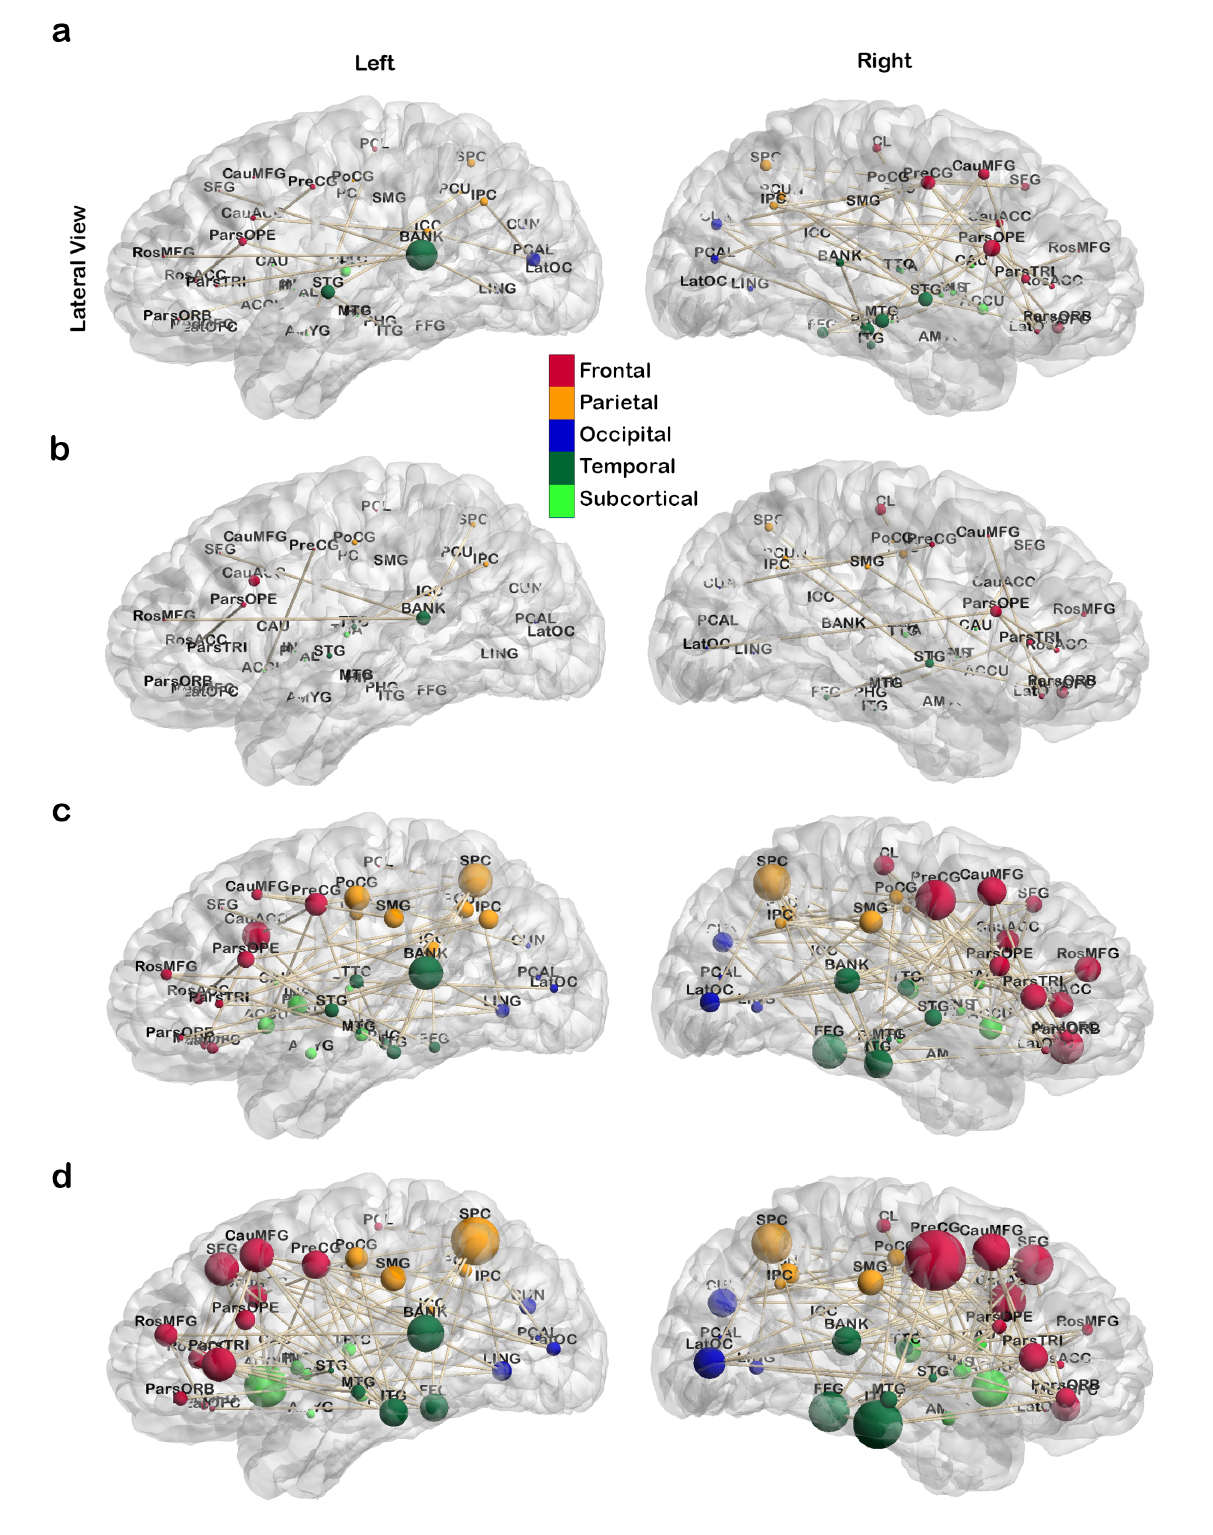
Figure 7. Degree distribution presented in the node size for the significant changes subnetworks identified using Benjamini– Hochberg procedure for FDR control with α = 0.05 from the 4 frequency band networks: ( a ) 0.12–0.25 Hz, ( b ) 0.06–0.12 Hz, ( c ) 0.03–0.06 Hz, and ( d ) 0.015–0.03 Hz. Edges are connections associated with significantly (with FDR control α = 0.05) changed